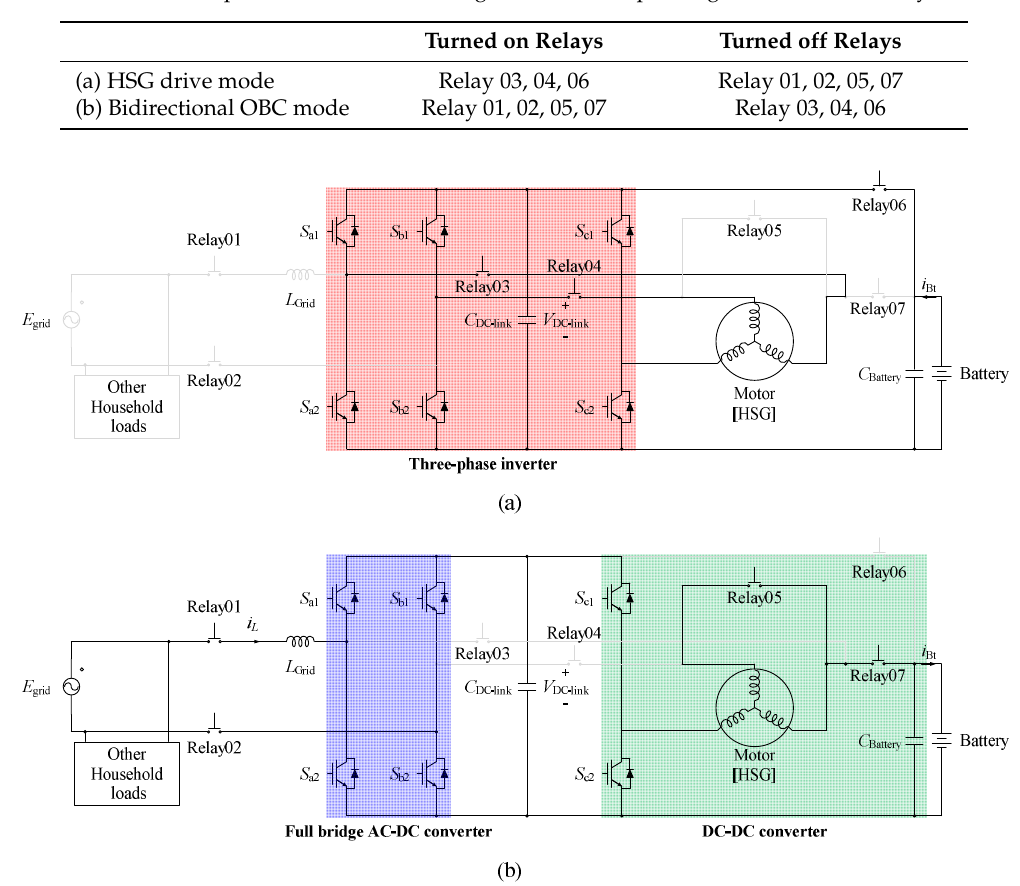
Figure 2. Circuit configuration for different operating modes: ( a ) HSG drive mode and ( b ) bidirectional OBC mode.